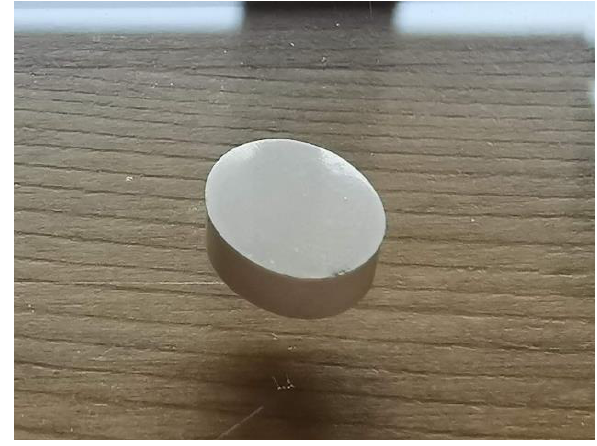
Figure 1. Biodentine sample (8 × 3 mm) removed from the PVC form.